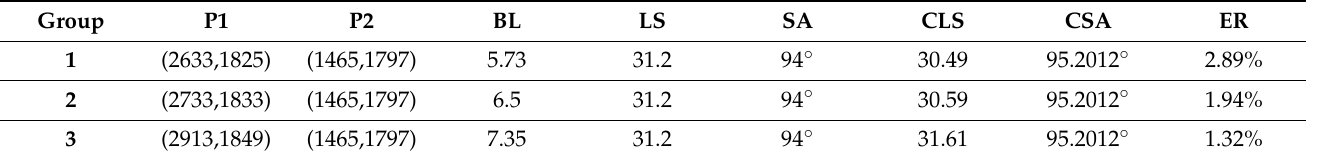
Table 2. Experimental